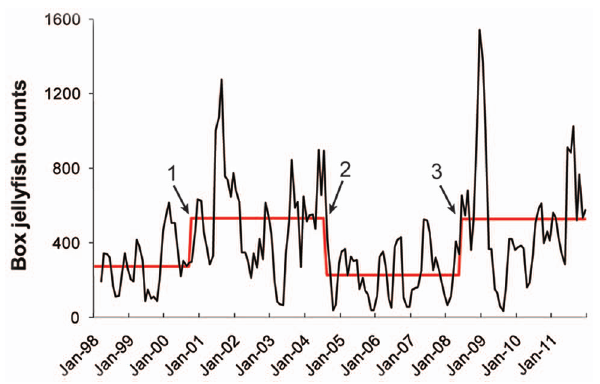
Figure 3. Monthly time-series of box jellyfish counts at Waikiki Beach. A three-month moving average smoothing approach was used to enhance visualization of the trend, depicted by the solid back line. The solid red line indicates mean box jellyfish beach counts during periods of no significant change determined by the Change Point Analysis (CPA). Three significant regime shifts in jellyfish numbers occurred during the 14-year period of study, corresponding to the periods previously identified by the GAM analysis: 1) 2000, 2) 2004, and 3) 2008. Dataset had no zeroes.